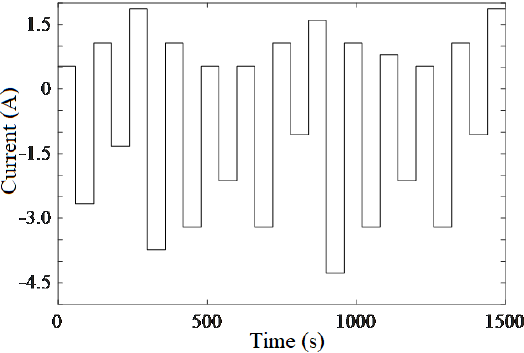
Figure 7. User-defined charge and discharge operating cycle.